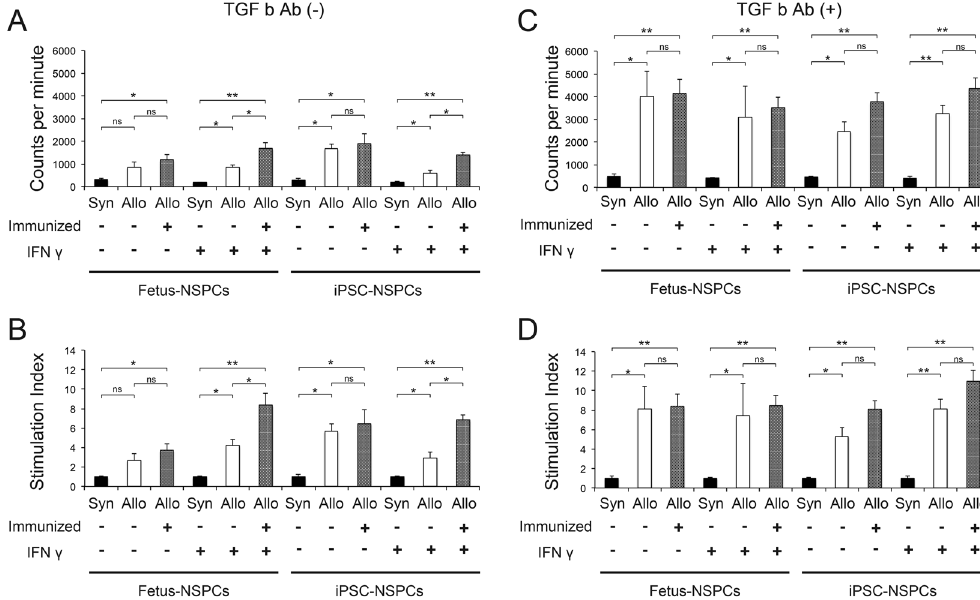
Figure 3. Fetus-NSPCs and 2A4F iPSC-NSPCs triggered allogeneic PBMC, but not syngeneic PBMC, proliferation in vitro . Fetus-NSPCs and 2A4F iPSC-NSPCs were irradiated and co-cultured with syngeneic mouse (C57BL6/J) PBMCs and allogeneic mouse (BALB/cA) PBMCs (pre-immunized and post-immunized) at a ratio of 1:10 with or without IFN γ and anti-TGF β receptor antibodies for 5 days (n = 3 independent experiments). ( A , C ) CPM measured in MLR assays without ( A ) or with ( C ) the anti-TGF β antibody. ( B , D